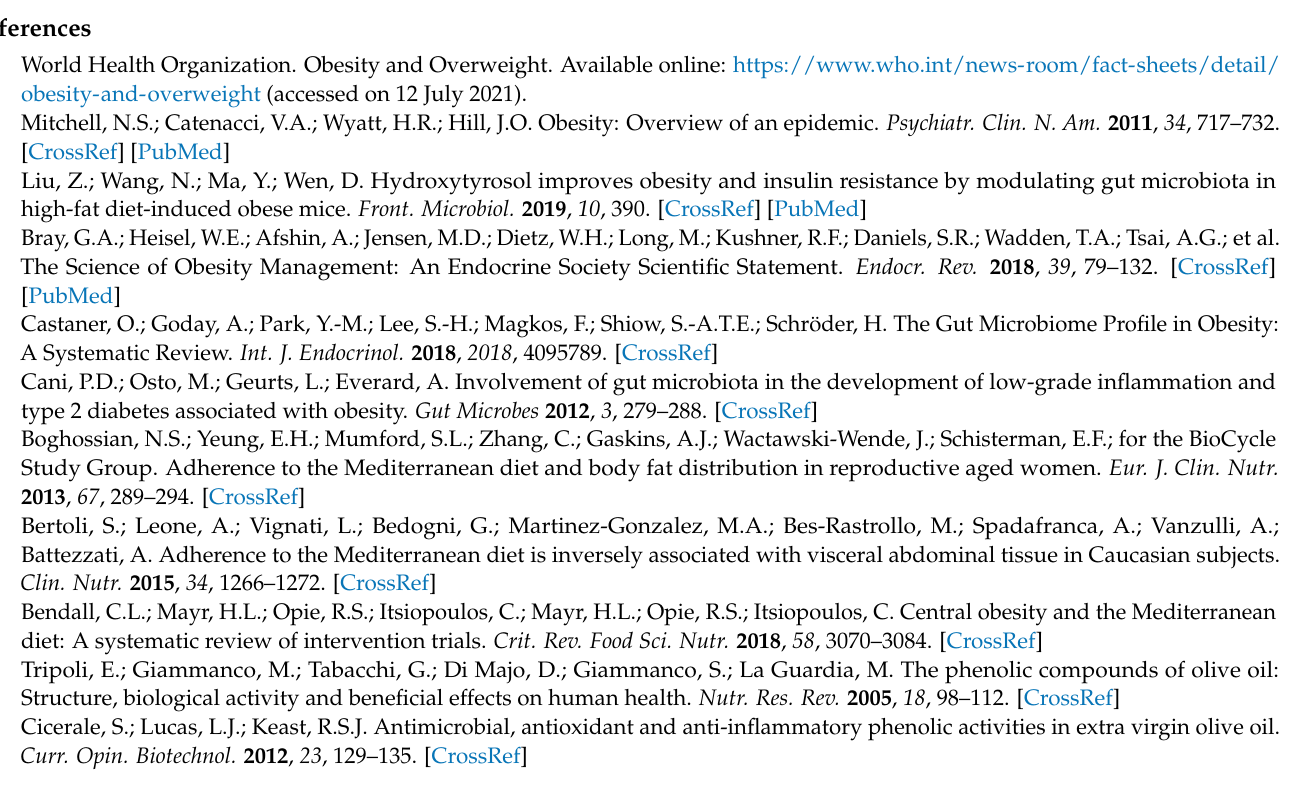
parameter, Figure S9: Representation of urine samples, Figure S10: UPLC-HRMS chromatogram of QCs-pooled, Figure S11: RSD of peaks for monitoring the validity of the analysis, Figure S12: Permutation